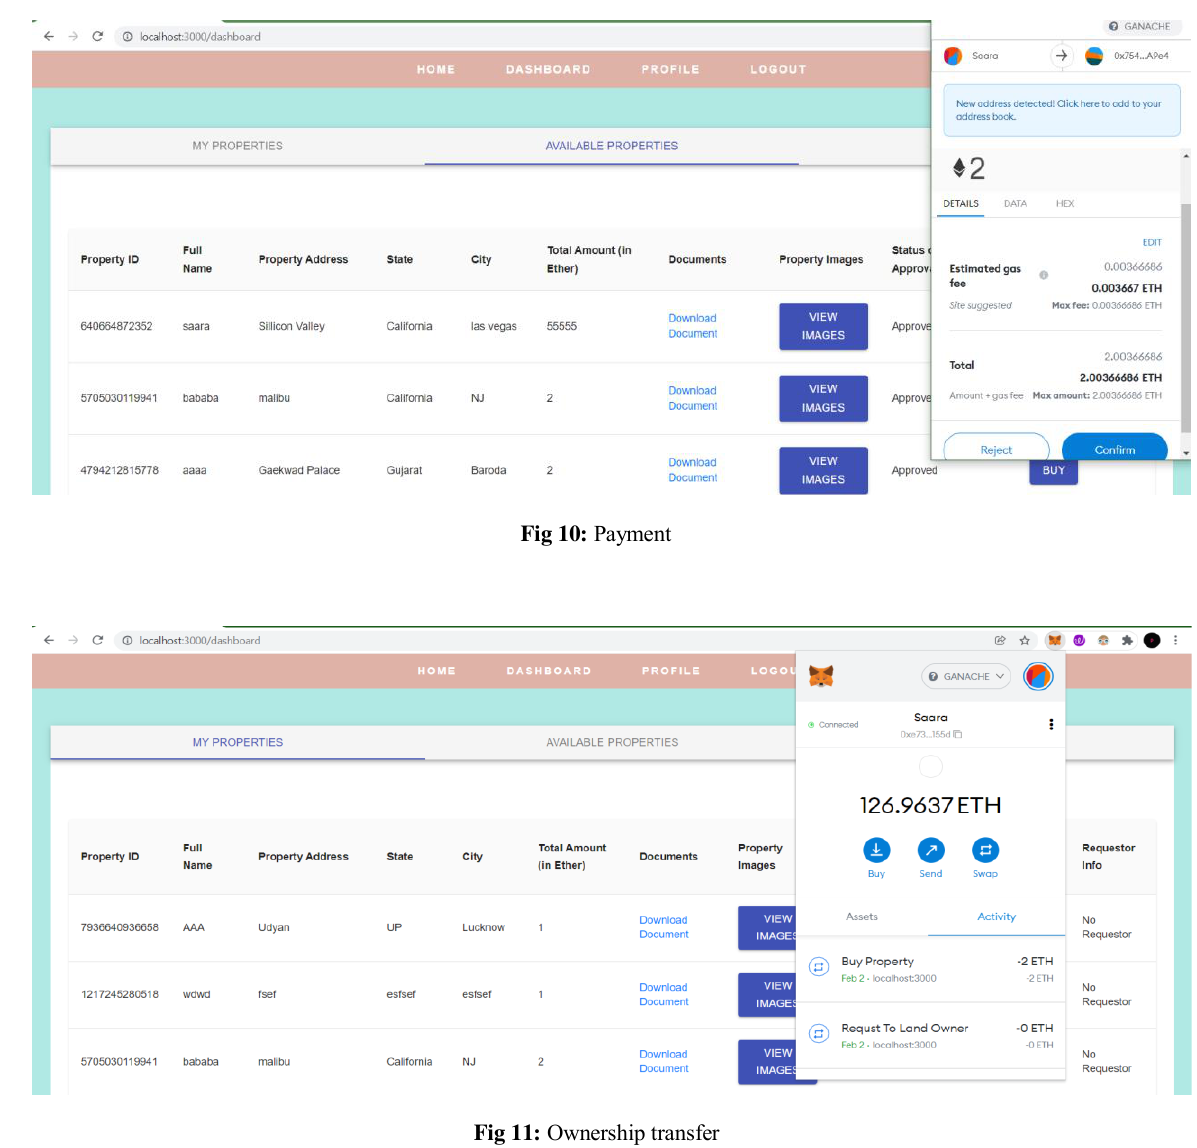
Fig 11: Ownership